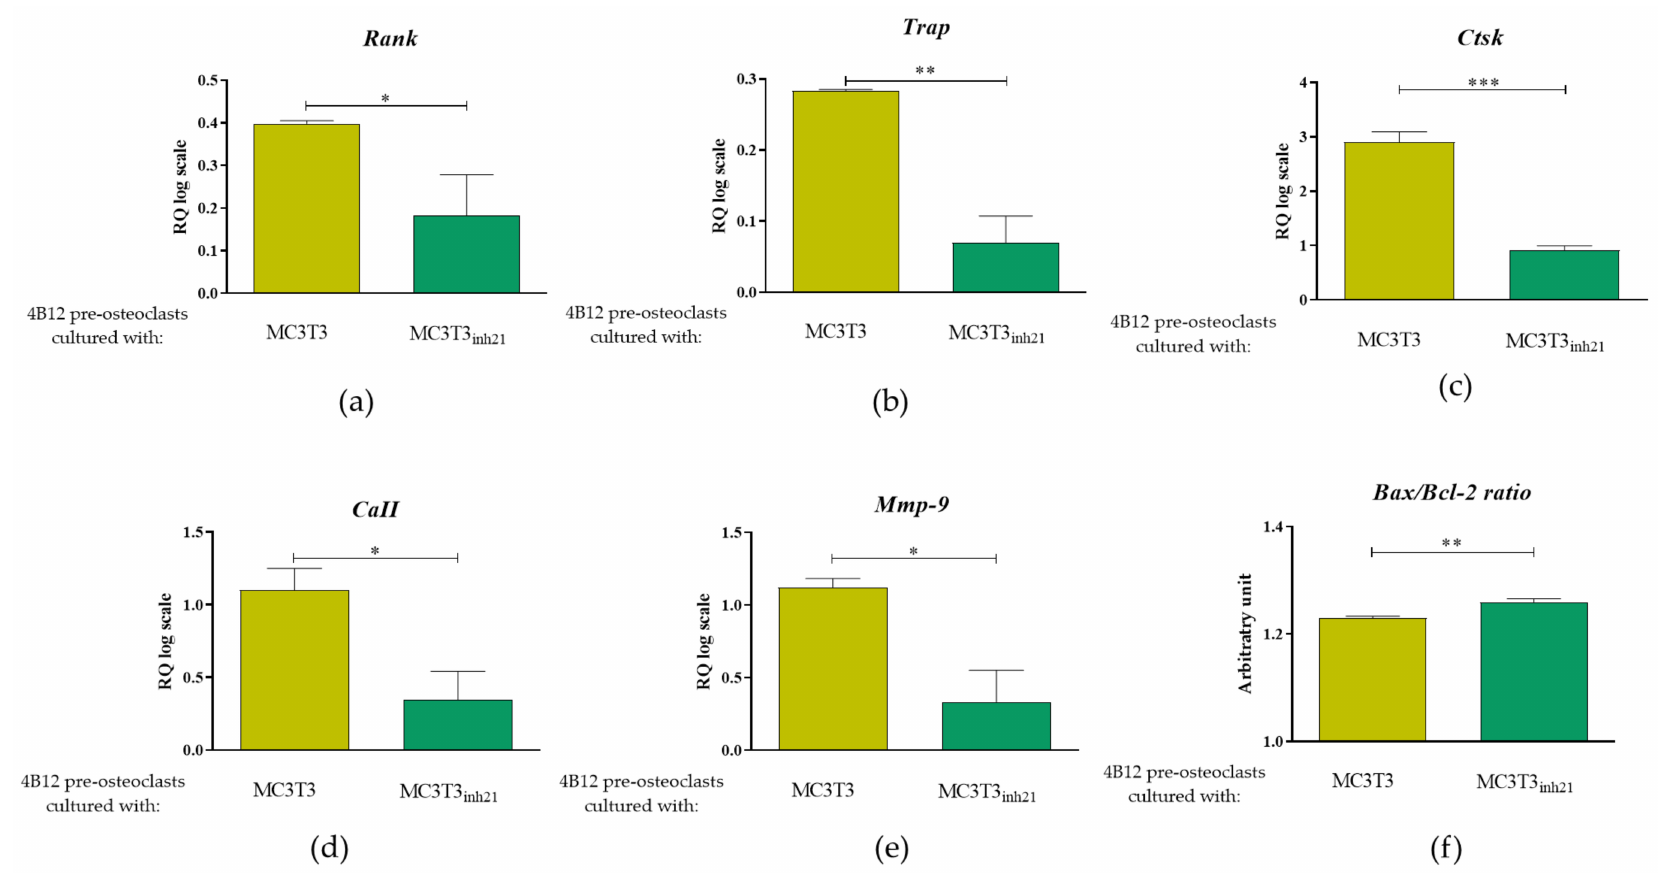
Figure 7. The expression of mRNA for typical osteoclast markers and molecules associated with apoptosis. The analysis included determination of transcript levels for receptor activator of nuclear factor κ B ( a ), tartrate-resistant acid phosphatase ( b ), cathepsin K ( c ), carbonic anhydrase II ( d ) and matrix metalloproteinase 9 ( e ). Moreover, the ratio of pro-apoptotic Bax and anti-apoptotic Bcl-2 gene was calculated ( f ). Significant di ff erences between groups are indicated with asterisks (* p < 0.05; ** p < 0.01 and *** p < 0.001), while non-significant di ff erences are marked as ns